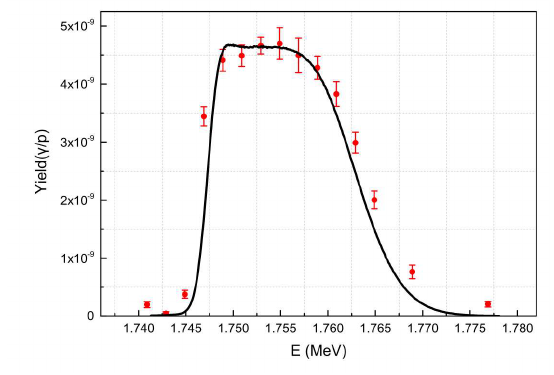
Figure 4. Absolute full-energy peak e ffi ciency of the HPGe de- tector determined with Geant4 simulation and the standard γ - sources.